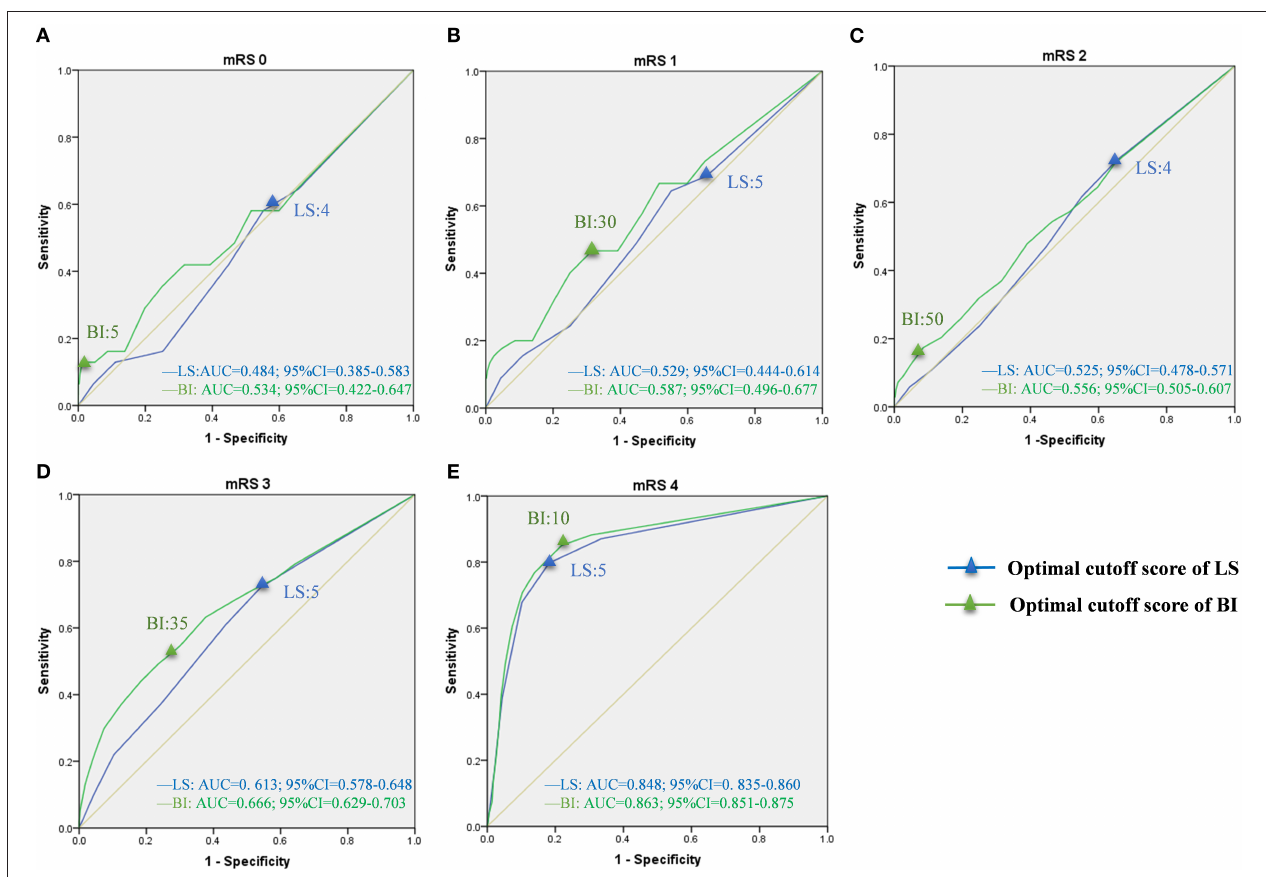
FIGURE 3 | ROC curves of LS and BI cutoff scores corresponding to mRS grades in the bedridden group. LS, Longshi Scale; BI, Barthel Index; mRS, modified Rankin Scale; ROC, Receiver Operating Characteristic; AUC, Area Under Curve; CI, Confidence Interval. (A) ROC curves for LS and BI cutoff scores in mRS 0. Optimal cutoff score: 4 and 5; Sensitivity: 64.5 and 64.5%; specificity: 34.3 and 34.7%; AUC: 0.484 and 0.534, respectively. (B) ROC curves for LS and BI cutoff scores in mRS 1. Optimal cutoff score: 4 and 30; Sensitivity: 64.4 and 46.7%; specificity: 44.9 and 68.5%; AUC: 0.529 and 0.587, respectively. (C) ROC curves for LS and BI cutoff scores in mRS 2. Optimal cutoff score: 4 and 50; Sensitivity: 72.5 and 17.4%; specificity: 34.6 and 91.5%; AUC: 0.525 and 0.556, respectively. (D) ROC curves for LS and BI cutoff scores in mRS 3. Optimal cutoff score: 5 and 35; Sensitivity: 72.1 and 49.1%; specificity: 46.0 and 76.6%; AUC: 0.613 and 0.666, respectively. (E) ROC curves for LS and BI cutoff scores in mRS 4. Optimal cutoff score: 5 and 10; Sensitivity: 79.7 and 85.1%; specificity: 81.8 and 78.1%; AUC: 0.848 and 0.863,